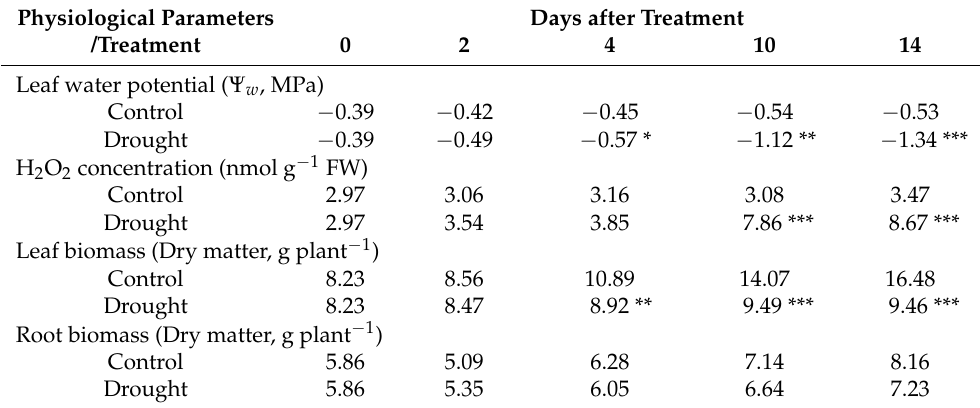
Table 1. Changes in the leaf water potential, H 2 O 2 concentration, leaf and root biomass in the well-watered (control) or drought-stressed plants for 14 days. Physiological